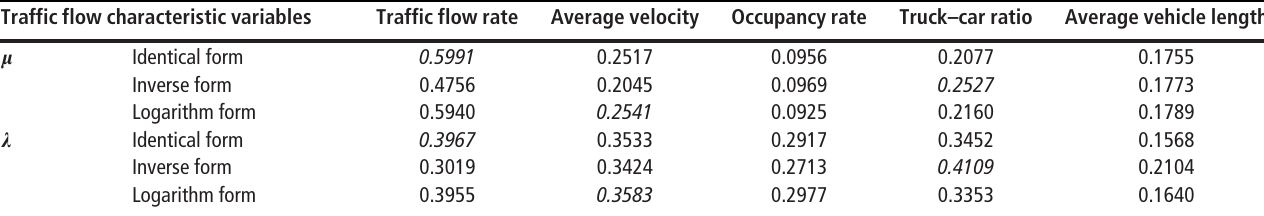
Table 7 Mean value of variable importance (AD4CHE) Traffic flow characteristic variables